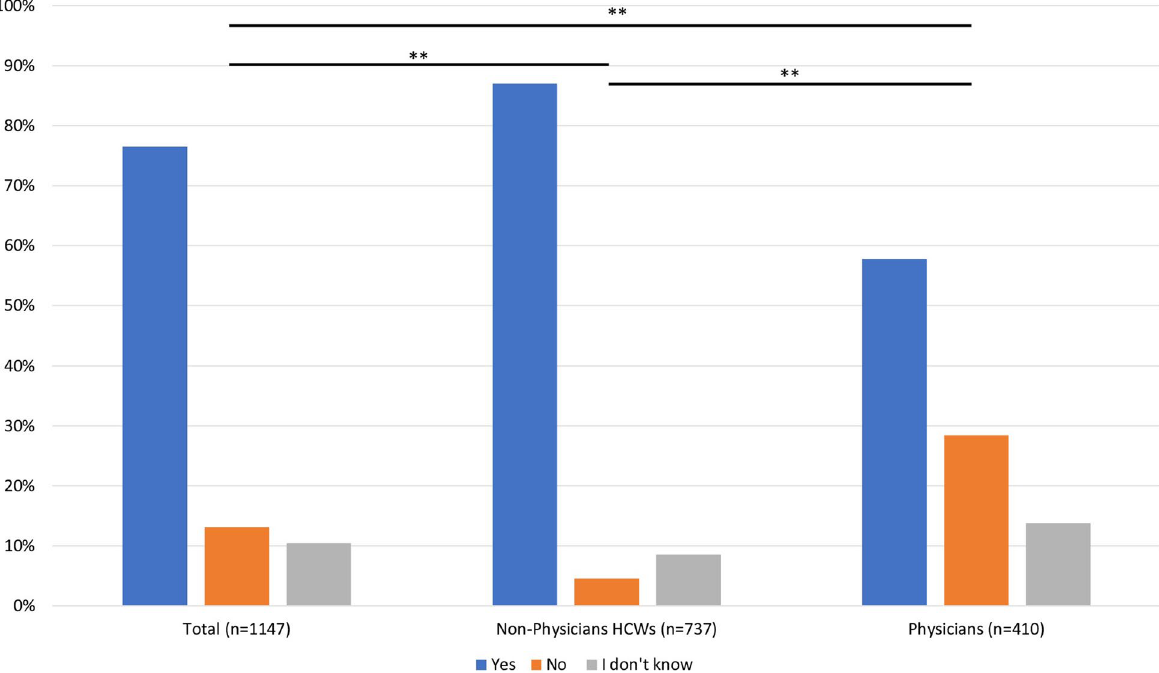
Fig. 1 Responses to the question “in general are you in favor of a law that would legalize an active medical assistance in dying (euthanasia/ physician-assisted